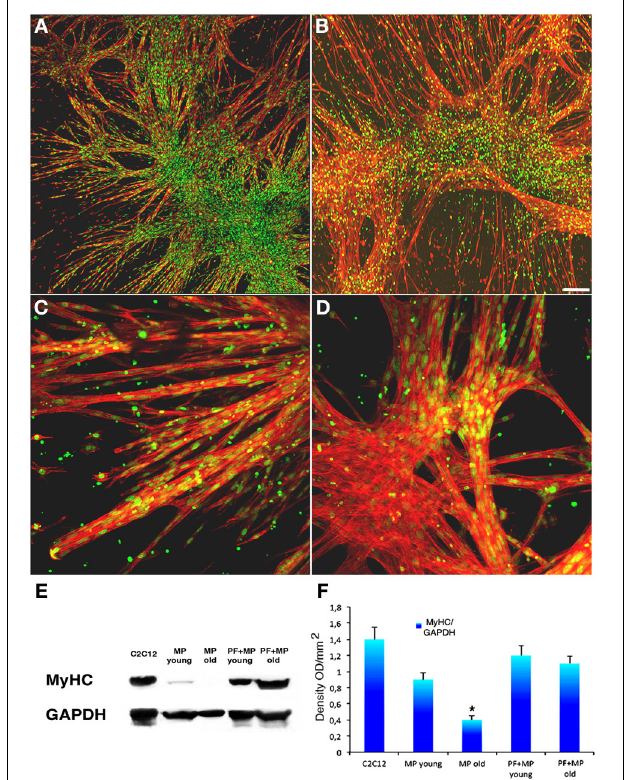
FIGURE 4 | PEG-fibrinogen re-establishes the myogenic capability of adult MP. (A,B) Confocal images of immunofluorescence labeling with an antibody against MyHC (red) and SYTOX Green for nuclei (green) on myotubes developed from young (A) and adult (B) pericytes cultured on a PEG-fibrinogen scaffold (5 days). (C,D) Enlarged view respectively of young (C) and adult (D) pericytes cultured on a PEG-fibrinogen showing multinucleated muscle fibers. (E) Representative Western blot of protein extracts from differentiated C2C12 cells as control and young and adult muscle-derived pericytes (MP) cultured on plastic or encapsulated in a PEG-fibrinogen scaffold (PF+), showing myosin heavy chain (MyHC) expression. (F) Densitometric analysis of three different Western blots quantifying the level of expression of MyHC. mean ± s.e.m., normalized to GADPH. ∗ p < 0 . 05 vs. Young MP. Scale bar: (A,B) 50 μ m; (C,D) 10 μ